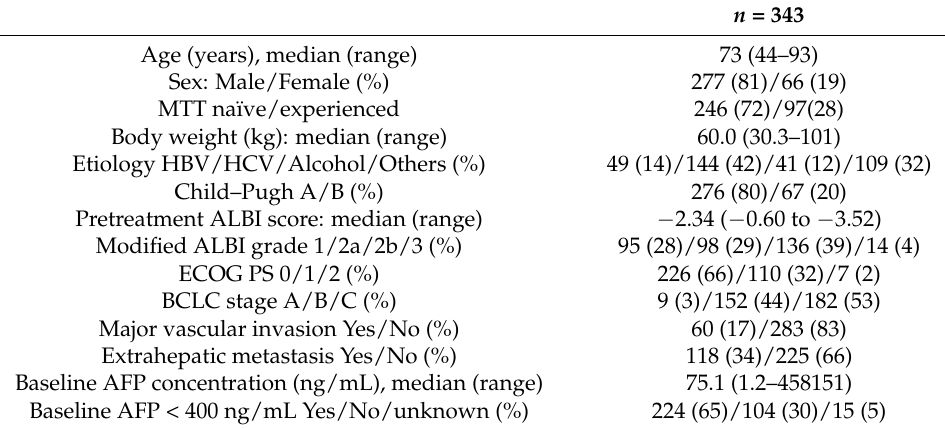
Table 1. Baseline characteristics of the